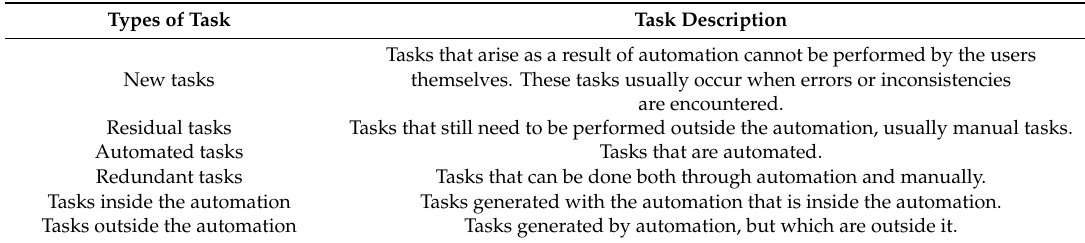
Table 1. Types of tasks (based on Verne, 2015 [7]; Verne and Bratteteig, 2016